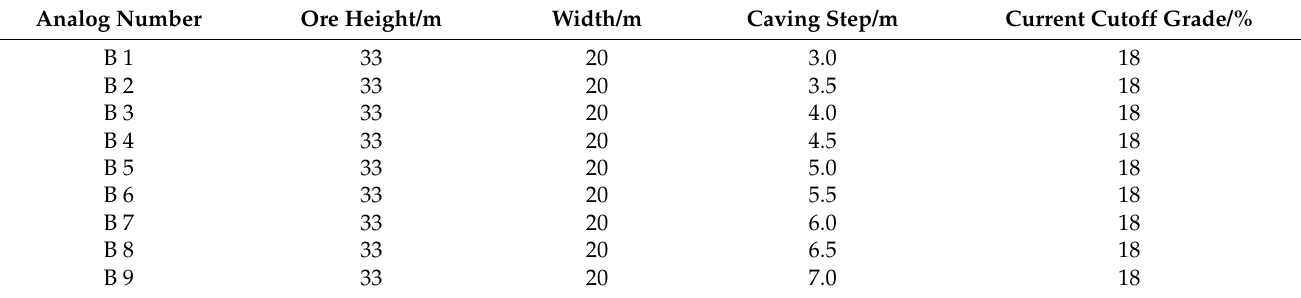
Table 5. Macro model simulation parameter